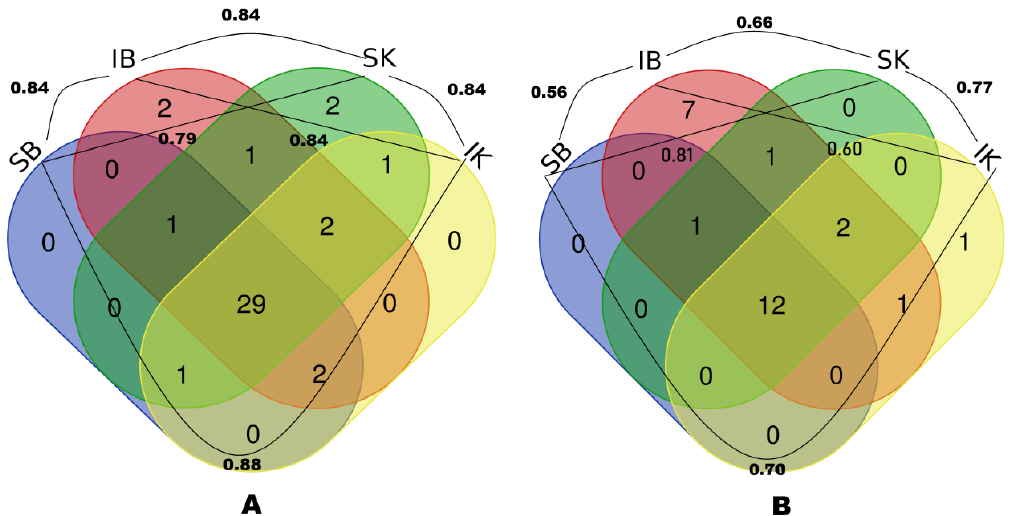
Figure 6. Venn diagrams showing the Jaccard indexes and overlap of ( A ) overall recorded wild food plants and ( B ) the most frequently reported wild food plants (quoted by more than 50% of the informants) among the four studied groups (IB: Ismaili Burusho, IK: Ismaili Kho, SB: Sunni Burusho, SK: Sunni Kho) in the Yasin Valley.